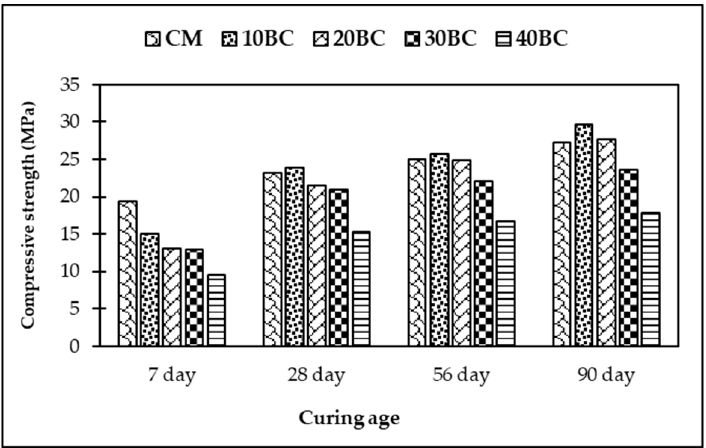
Figure 9. Compressive strengths at different ages.